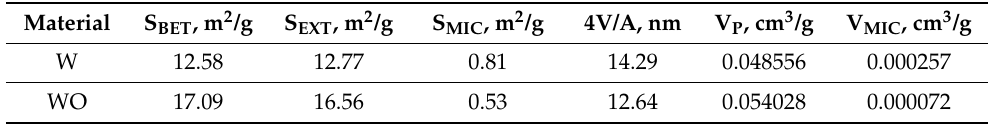
Table 2. Characteristic of vermiculite grades based on BET